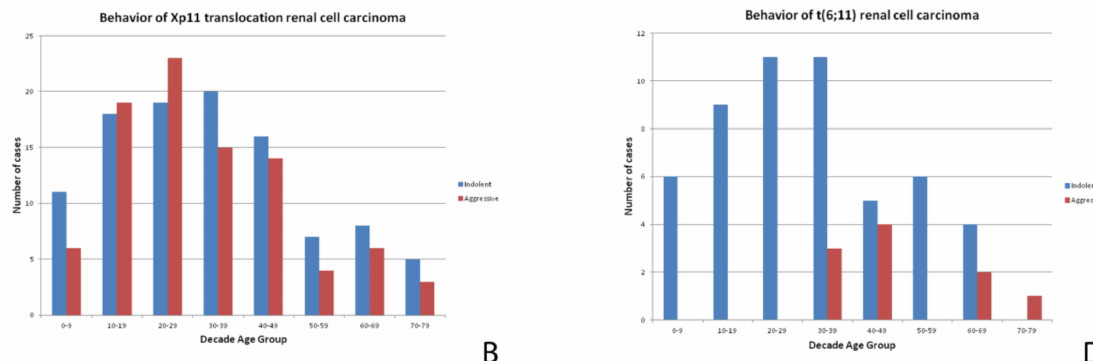
Figure 1. A chart showing the incidence (number of patients with tumors divided by the number of patients in the age group) of Xp11 translocation renal cell carcinomas ( A ) and t(6;11) renal cell carcinoma ( C ) at di ff erent ages. A chart showing the clinical behavior of Xp11 translocation renal cell carcinomas ( B ) and t(6;11) renal cell carcinoma ( D ) at di ff erent